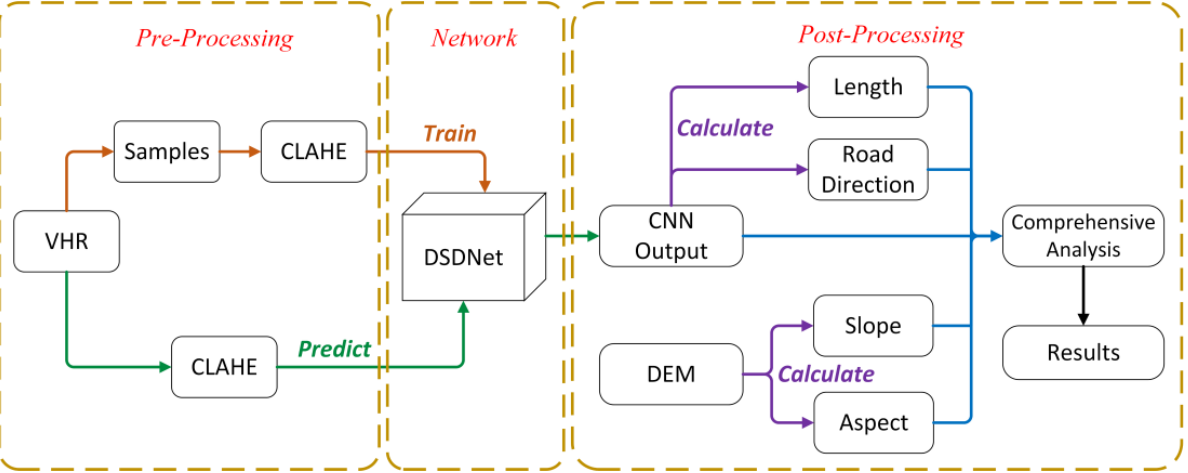
Figure 1. Overall flow chart of road extraction.